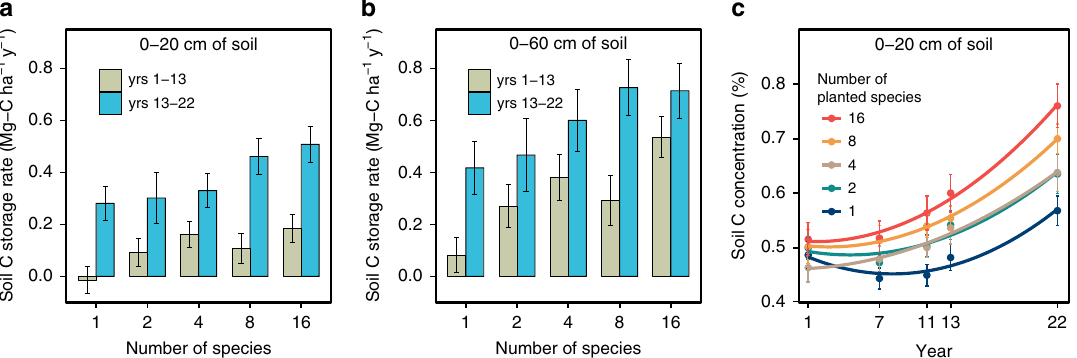
Fig. 1 Change in soil C over 22 years. a , b Average annual soil C storage rates over years 1 – 13 (green bars) and years 13 – 22 (blue bars) in upper 20 cm of soil ( a ) and in upper 60 cm ( b ) (Supplementary Table 1). Bars are means with standard errors. c Dynamics of soil C concentration in upper 20 cm of soil for plots planted with 1, 2, 4, 8, or 16 perennial grassland species (Supplementary Table 2). Dots are means with standard errors; fi tted curves are